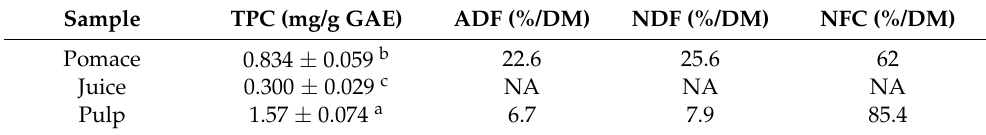
Table 2. Total polyphenolic (mg/g GAE) and fiber content of apple products. Sample